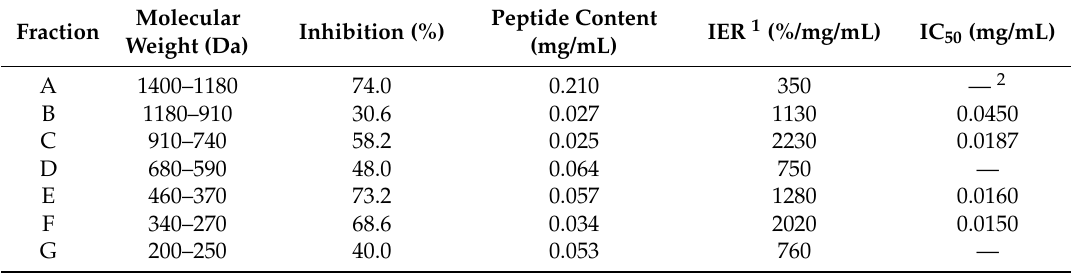
Table 3. ACE IC 50 of the size exclusion chromatographic fractions obtained from PN-1 after digestion by gastrointestinal proteases.